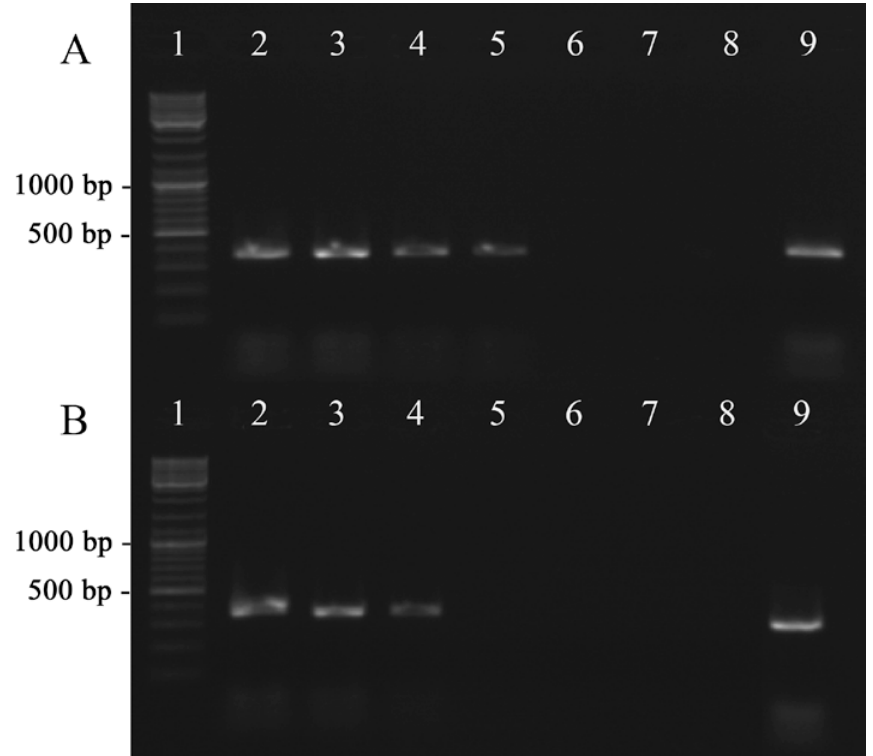
Figure 3. Gel electrophoresis of nested-PCR products obtained with Phytophthora pistaciae specific primers ITS-SF1 and ITS-SR1 using centrifugation (A) or filtration (B) methods for collecting zoospores of P. pistaciae in soil extract. (1) 100 bp DNA ladder; DNA extracted from a suspension contained 1.5 × 10 3 (2), 500 (3), 100 (4), 50 (5), 10 (6) zoospores in mL soil extract, negative control with sterile soil extract (7), negative control with HPLC water (8), positive control with DNA ex - tract of SURf14 isolate